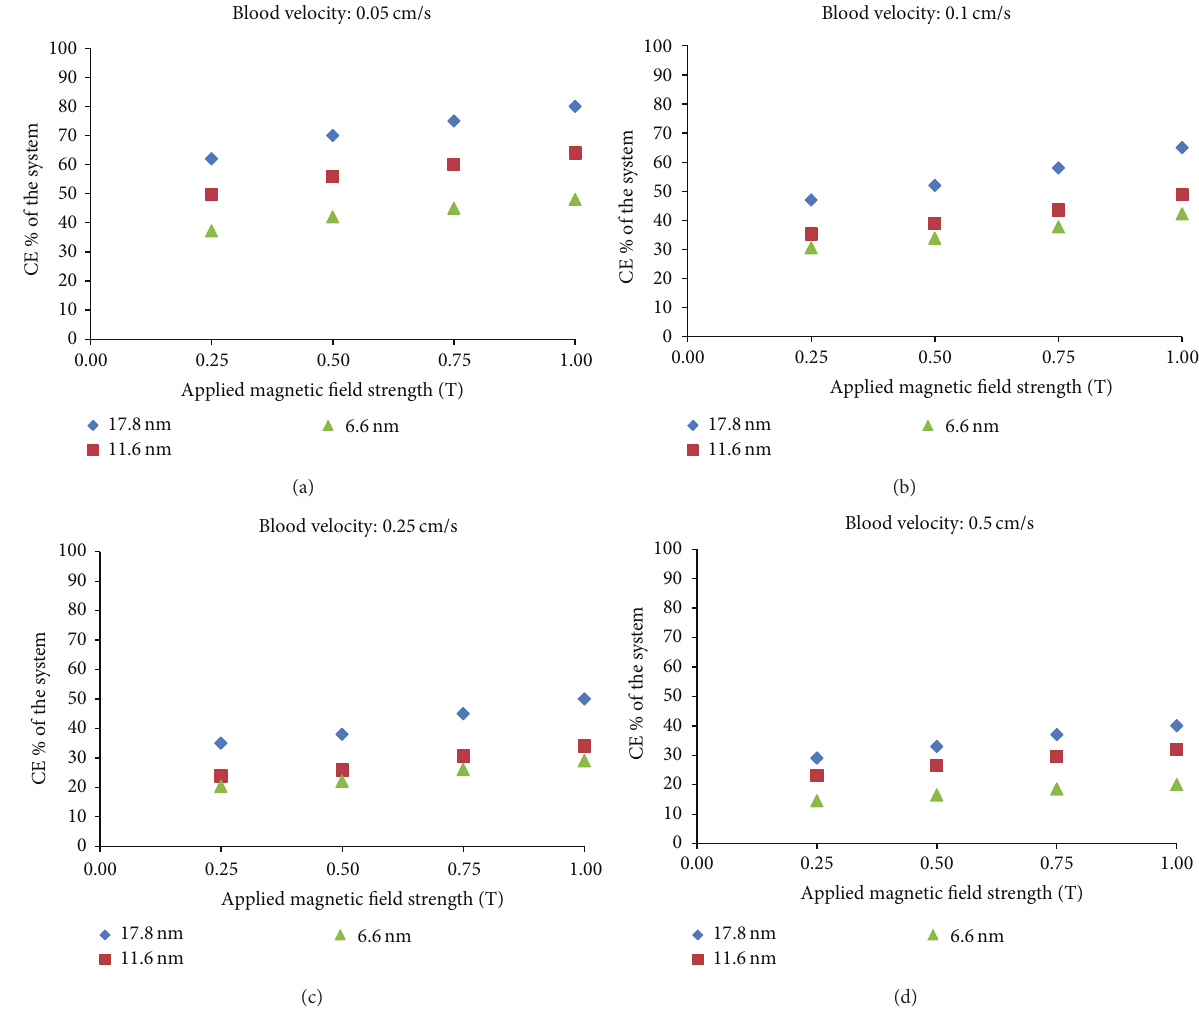
Figure 2: CE of the SA-MDT system is plotted with different magnetic field strengths (0.25, 0.50, 0.75, and 1T) and blood velocities (0.05, 0.1, 0.25, and 0.5